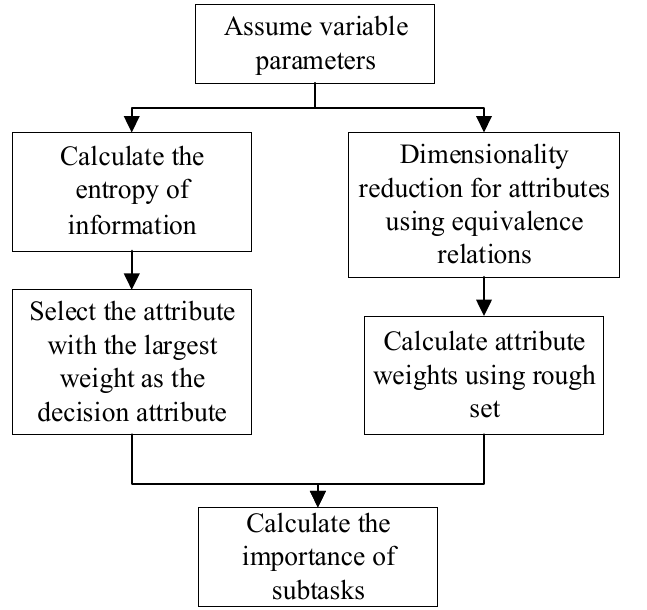
Figure 5. Flow chart of decomposition.